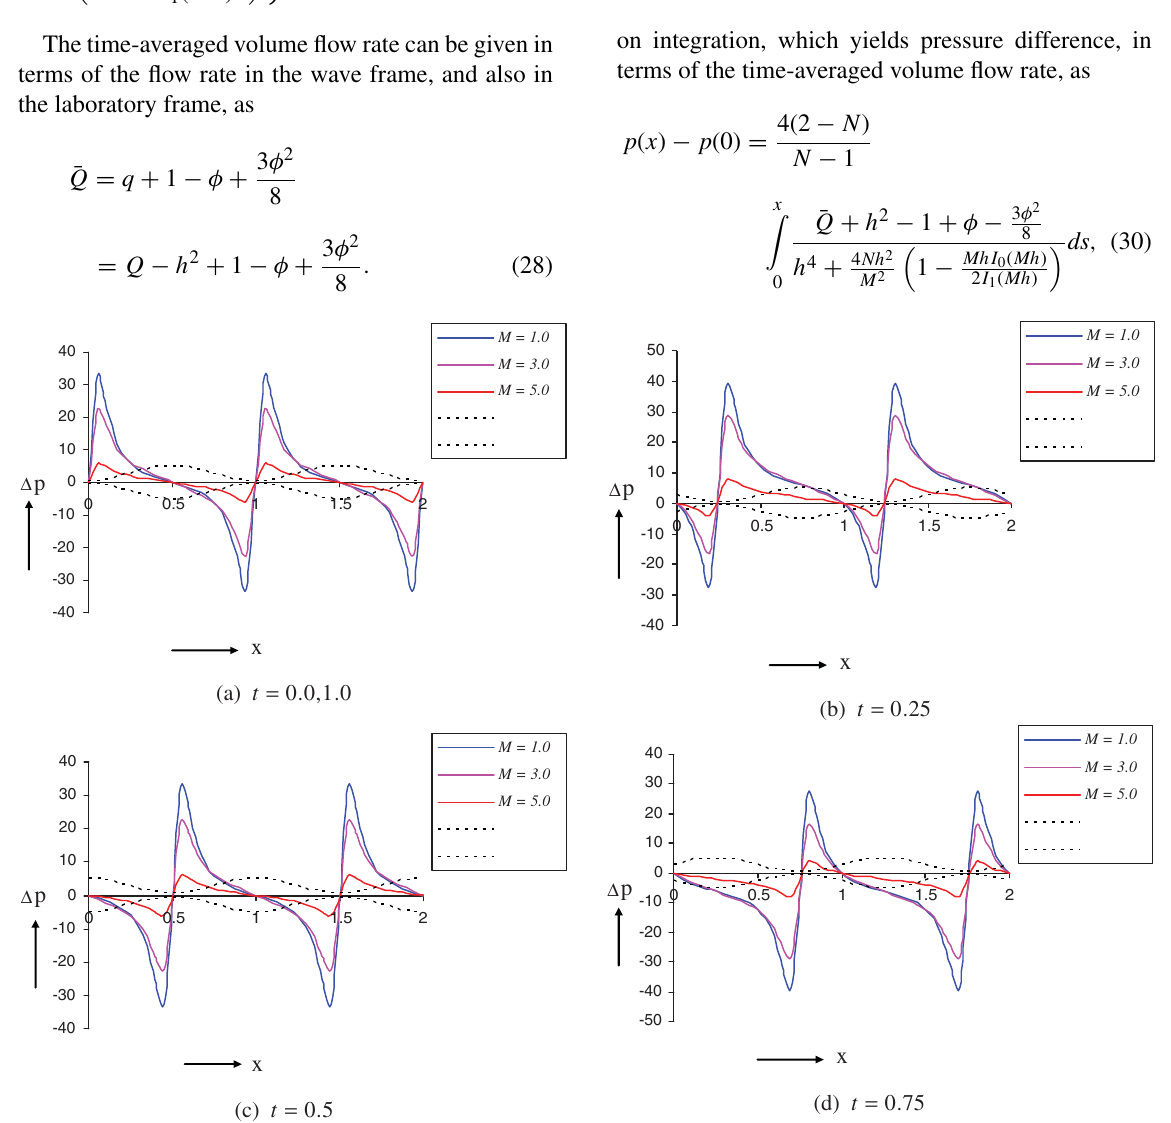
Fig.3. PressuredistributionalongtheaxialdistanceofthefinitelengthtubeatfivetimeinstantsbasedonEq.(23).Dottedlines( ······ )represent the position of wave, whereas continuous lines (—) represent the pressure distribution for M =1.0–5.0, φ =0.9, N =0.50 and l